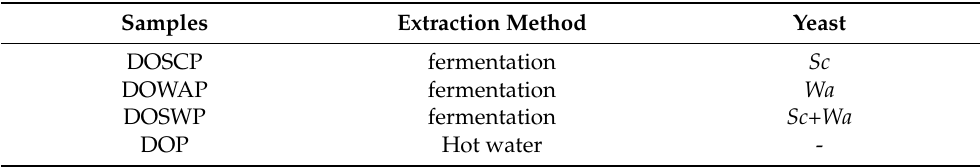
Table 1. Polysaccharides extraction